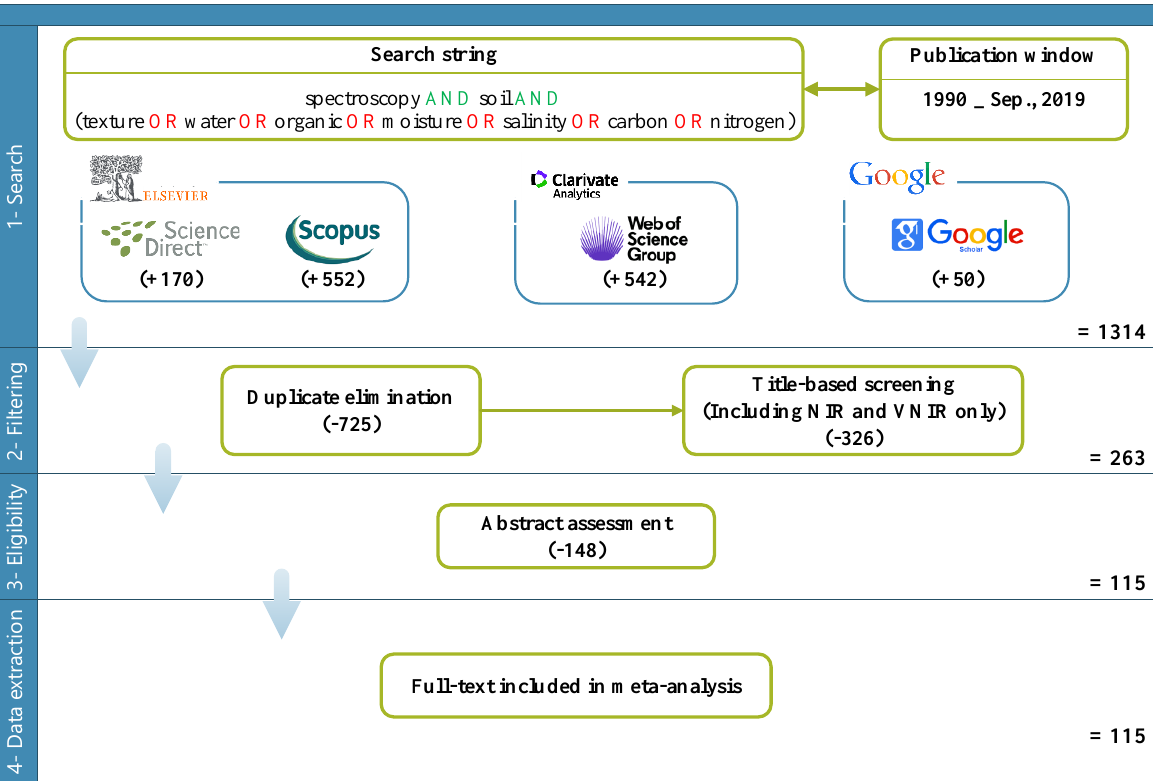
Figure 1. Flow diagram of the systematic review. Numbers in parenthesis correspond to the number of selected (+) or eliminated (−) manuscripts at each stage.